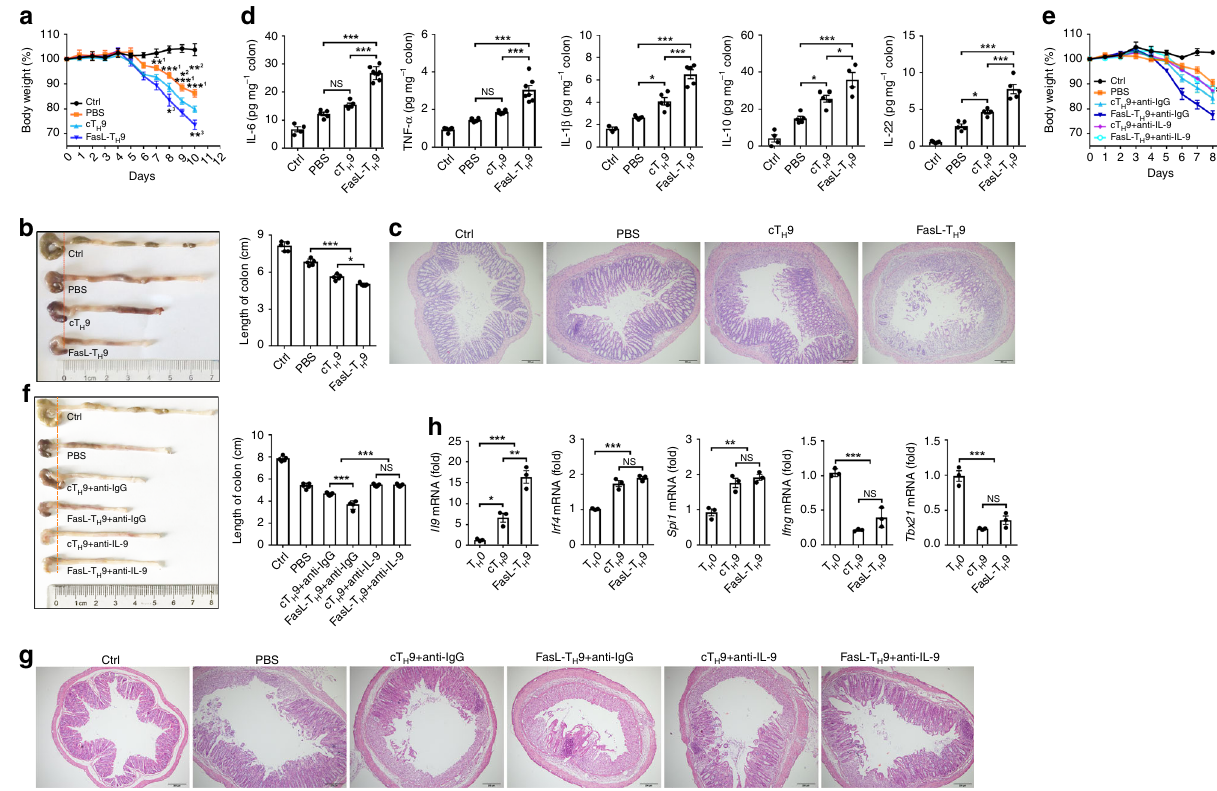
Fig. 5 FasL-T H 9 exacerbate murine in fl ammatory bowel disease (IBD) via interleukin-9 (IL-9). a – d Weight ( n = 5) ( a ), colonic length ( n = 5) ( b ), hematoxylin – eosin-stained colonic tissue sections ( c ), and enzyme-linked immunosorbent assay (ELISA) measurement of the indicated cytokines released by colonic tissue ( n = 3 – 6) ( d ) of 2.5% dextran sulfate sodium salt (DSS) (w/v)-induced IBD mice that received an intravenous transfer of 2 × 10 6 conventionally differentiated T H 9 cells (cT H 9) or Fas ligand (FasL)-T H 9. e – g Weight ( n = 5) ( e ), colonic length ( n = 5) ( f ), and hematoxylin – eosin-stained of colonic tissue sections ( g ) of 2.5% DSS (w/v)-induced IBD mice that received an intravenous transfer of 2 × 10 6 cT H 9 or FasL-T H 9 plus intravenous injection of 100 µ g of anti-IgG- or anti-IL-9-neutralizing antibodies every other day. h Real-time PCR measurement of the indicated genes in CD45.1 + cT H 9 or FasL-T H 9 sorted from lamina propria lymphocytes (LPLs) isolated from 2.5% DSS (w/v)-induced CD45.2 + IBD mice that received an intravenous transfer of 1 × 10 7 CD45.1 + cT H 9 or FasL-T H 9 for 5 days ( n = 3). Scale bar = 200 μ m. NS, not signi fi cant; * P < 0.05, ** P < 0.01, and *** P < 0.001 (unpaired Student ’ s t test: a , b (right), d – f (right), and h ). 1, compared with FasL-T H 9; 2, compared with cT H 9; and 3, compared with cT H 9. Representative results from three independent experiments are shown (mean and